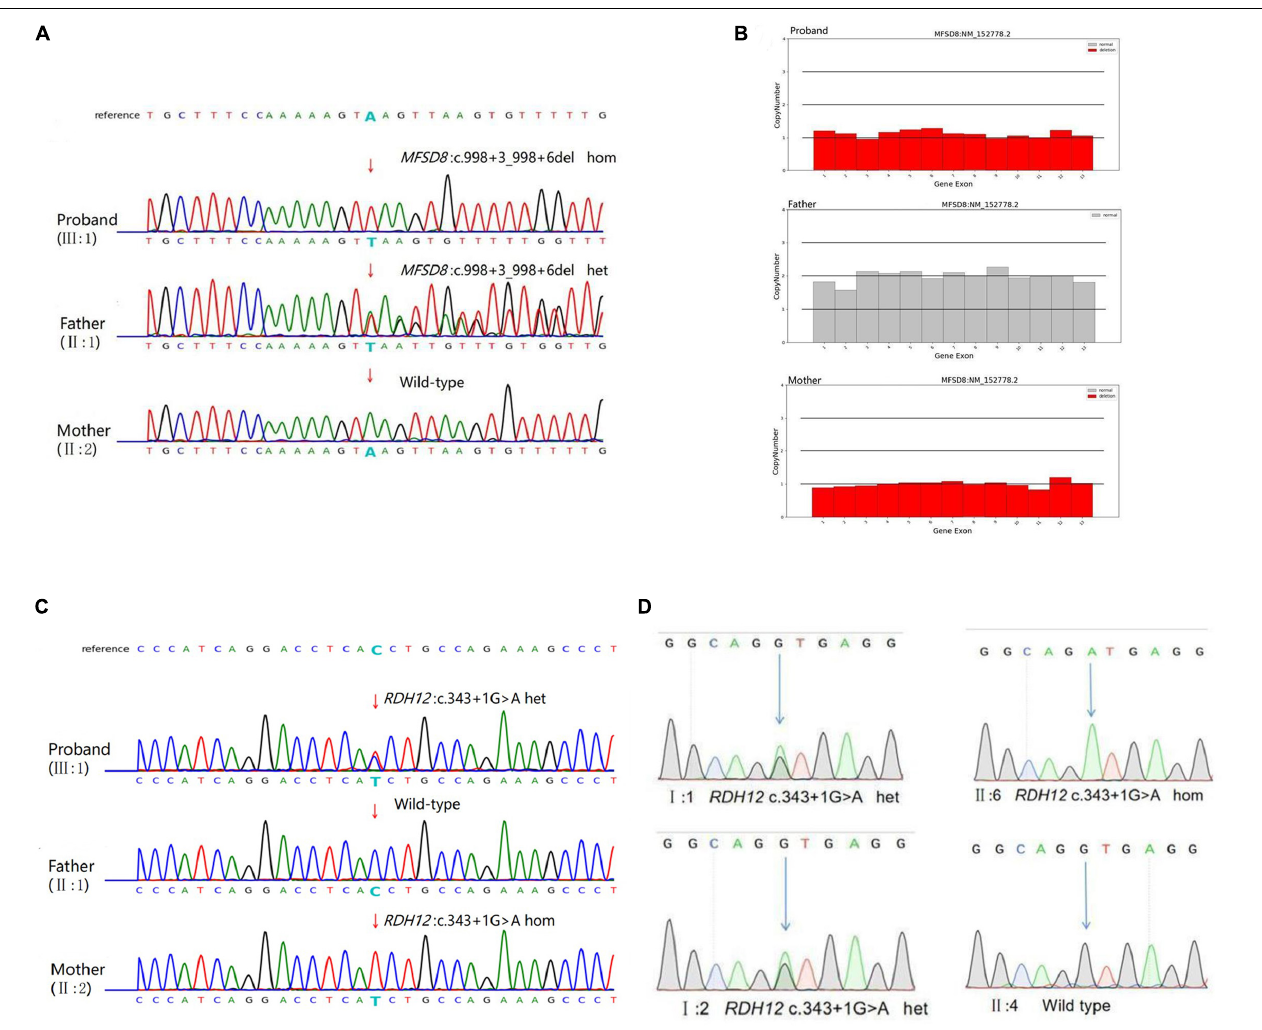
FIGURE 3 | Genetic characterization of the family. (A) The candidate causal mutation c.998+3_998+6del of MFSD8 discovered via WES was confirmed by Sanger sequencing. A homozygous deletion (c.998+3_998+6del) in MFSD8 was found in the proband and was not detected in his mother. A heterozygous mutation was found in his father. The red arrow indicates the site of the mutation. (B) MFSD8 detected by WES-CNV in the family. WES-CNV reveals an obvious deletion in the proband inherited from his mother. There was nothing abnormal in the same position of his father. (C) The mutation c.343+1G > A of RDH12 was confirmed by Sanger sequencing. A heterozygous mutation (c.343+1G > A) in RDH12 was found in the proband. His father did not show this mutation. A homozygous mutation (c.343+1G > A) in RDH12 was found in his mother. The red arrow indicates the site of the mutation. (D) Cosegregation analyses among the consanguineous family. Both parents (I:1 and I:2) were heterozygous for c.343+1G > A of RDH12 . The sister (II:6) with a similar phenotype to II:2 had the same homozygous mutations, and another sister (II:4) with a normal phenotype was wild type. The blue arrow indicates the site of the